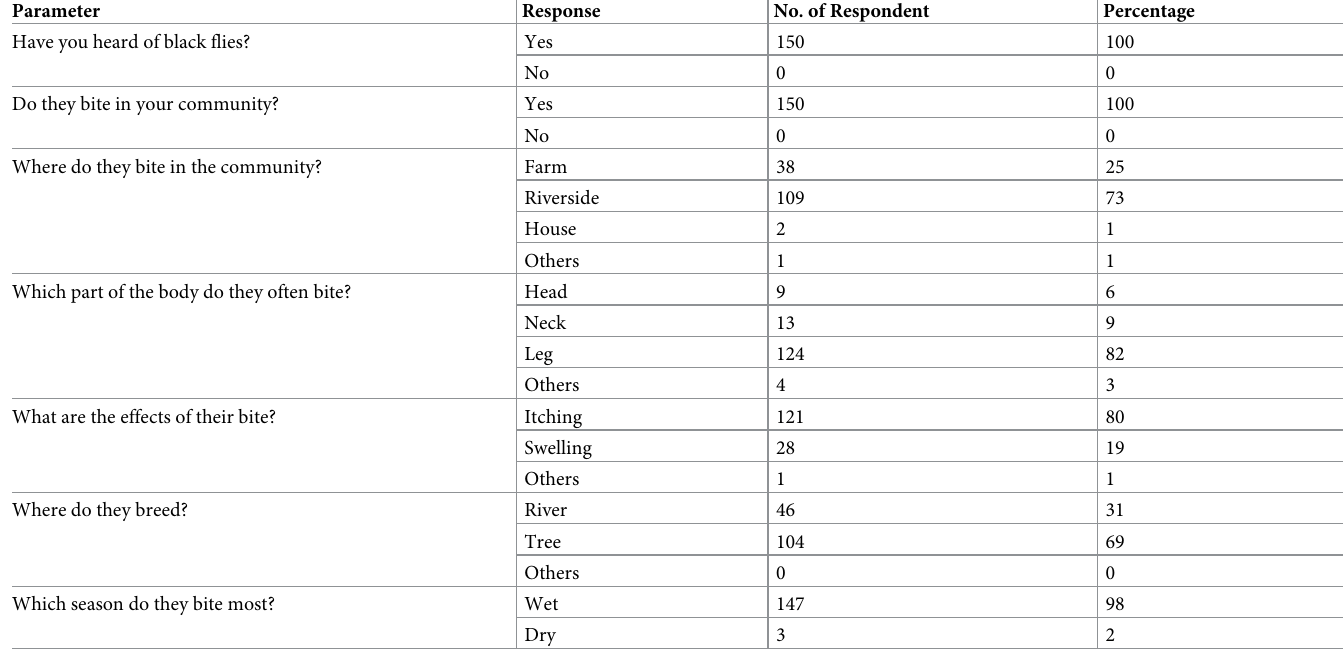
Table 2 summarizes the knowledge and attitude of respondents on bioecology of S . damno- sum complex. All the respondents 150 (100%) affirmed that they know black flies when probed of the presence of the fly in the community with its local or common name ‘Amukuru’ i.e caus- ing itching. They unanimously established the fact that the flies bite seriously in the commu- nity. A larger percentage (73%) of the respondents established that the flies bite mostly at the riverside (Owena River), while 27% claimed they bite mostly at the farm. Information from the Focus Group Discussion (FGD) corroborated these observations. The flies were believed to be biting any part of the exposed body but with affinity for the leg (124) (82%) than any other Table 2. Knowledge and attitude of respondents on bioecology of Simulium damnosum complex.